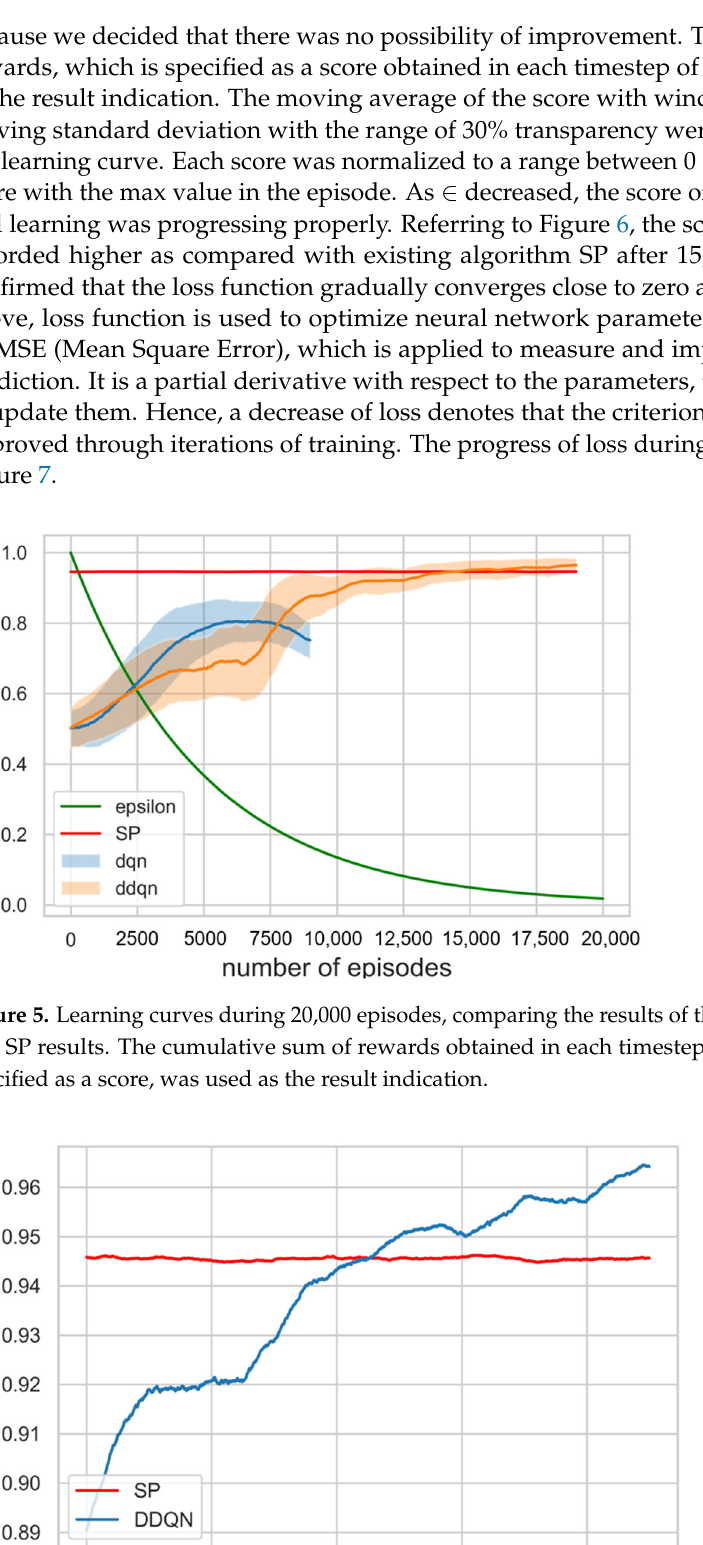
Figure 7. Loss values at each episode under 0.4. It was confirmed that the loss function gradually converges close to zero as well. 4.3. Single Node Simulations The training was successfully performed in the single node that has the output port structure shown in Figure 3. Simulations were conducted under the same environmental variables as the existing algorithm by applying a trained agent for evaluation. Figure 8 indicates the comparison between the trained deep learning model and the existing algo- rithms. All algorithms were tested 10 times; thus, the distribution of data could be consid- ered. Unlike the environment of DDQN learning, with 200% of maximum link utilization (i.e., priority 1 and priority 2 packets generated at a period of 1 timeslot), all packet gen- eration periods were set to 2 timeslots and tested. The deadlines of all flows were fixed at 7 timeslots, and the packet number of each flow was set to 40. The current delay was de- signed considering remaining hops since we assumed that packet has a smaller remaining hop means packet was sent from source longer timeslots ago. As could be seen from Fig- ure 8, the trained DDQN achieved 100% of a normalized score even though parameters were changed, proving that it would adapt well to dynamic environments. On the other hand, the existing algorithms remained in average performance at around 90%~92%. This result suggests that the DDQN could guarantee deadline requirements for more packets